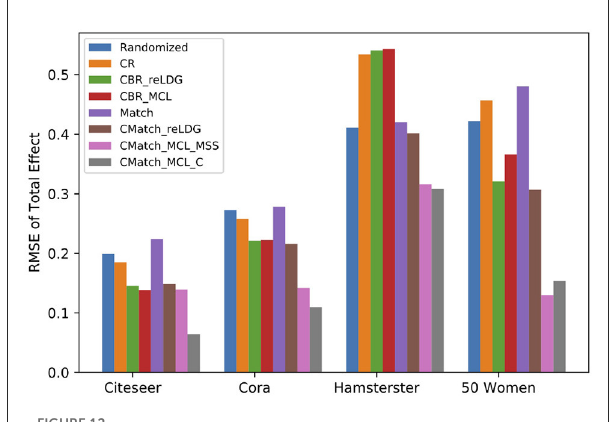
FIGURE12 RMSE of total effect in the presence of direct interference ( e.p = edge-weight ). CMatch MCL